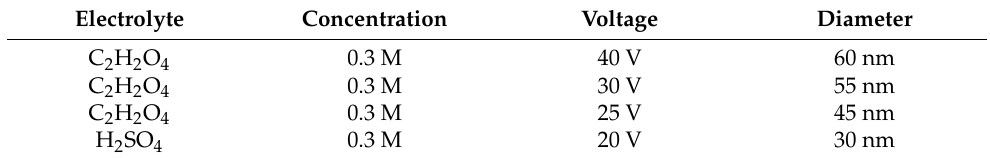
Table 1. Anodization conditions and electrolyte used for AAO template fabrication. The anodization was carried out overnight at 0 ◦ C. The time and temperature were kept same for all the samples. Electrolyte